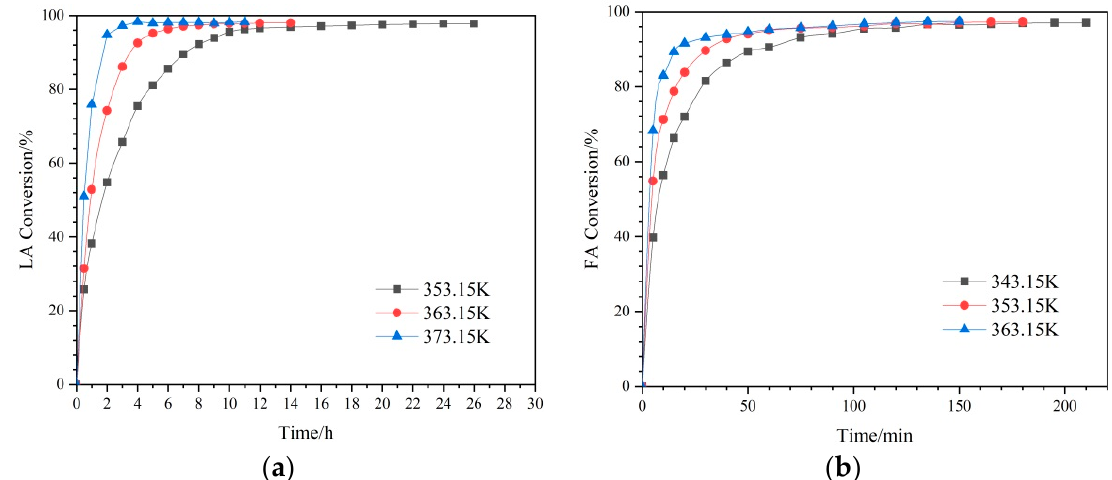
Figure 2. Kinetic data of ( a ) LA with 20% catalyst dosage at various temperature and ( b ) FA with 5%.